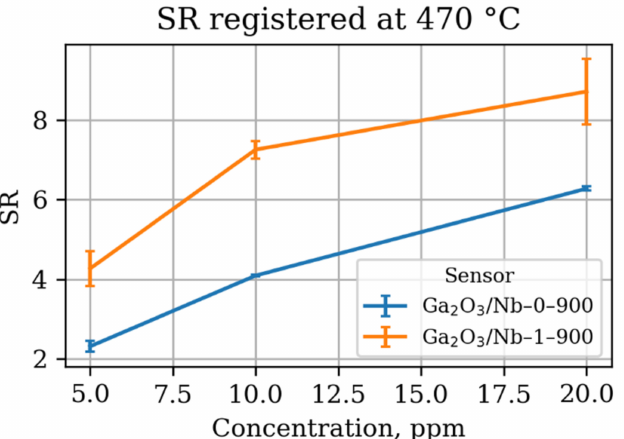
Figure 9. Dependence of sensor response of ( a ) Ga 2 O 3 -based materials without Nb doping annealed at 900 ◦ C and ( b ) Ga 2 O 3 -based materials with 1% mol Nb doping annealed at 900 ◦ C at different working temperatures towards acetone on concentration in dry air.